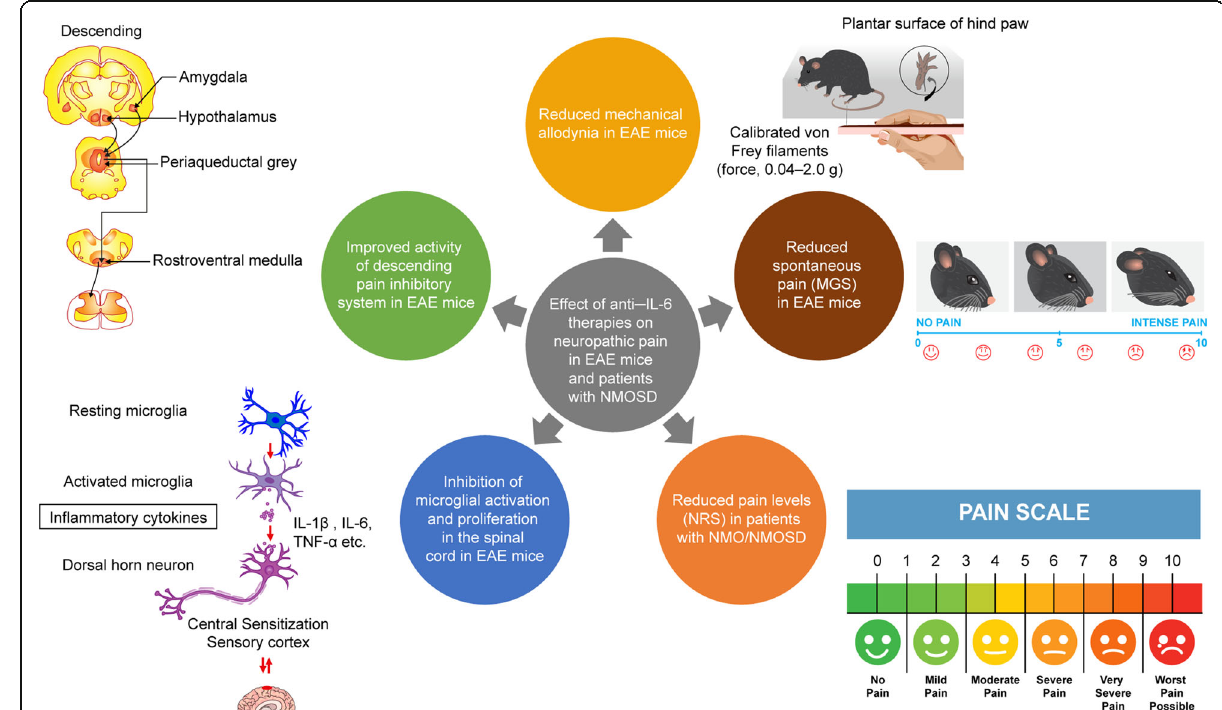
Fig. 3 Effects of anti – IL-6 therapies on neuropathic pain in preclinical and clinical studies. EAE, experimental autoimmune encephalomyelitis; IL, interleukin; MGS, Mouse Grimace Scale; MS, multiple sclerosis; NMO, neuromyelitis optica; NMOSD, neuromyelitis optica spectrum disorder; NRS, numerical rating scale; TNF- α , tumor necrosis factor